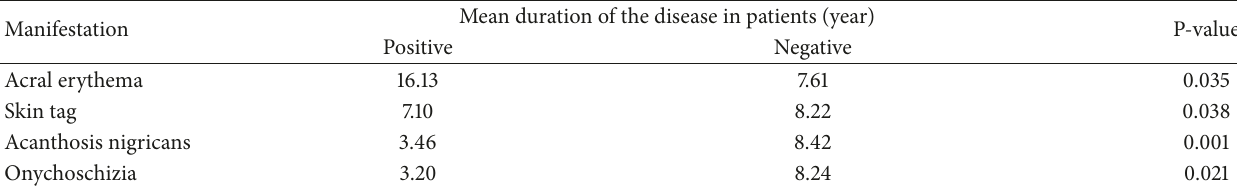
Table 2: Association of DM related cutaneous and nail manifestations with DM duration.